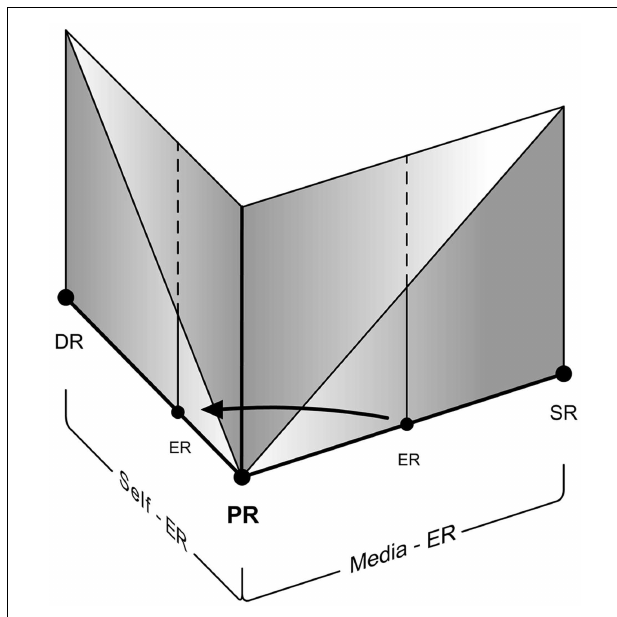
FIGURE 11 |An example of presence shift toward Self-ER triggered during Media-ER.